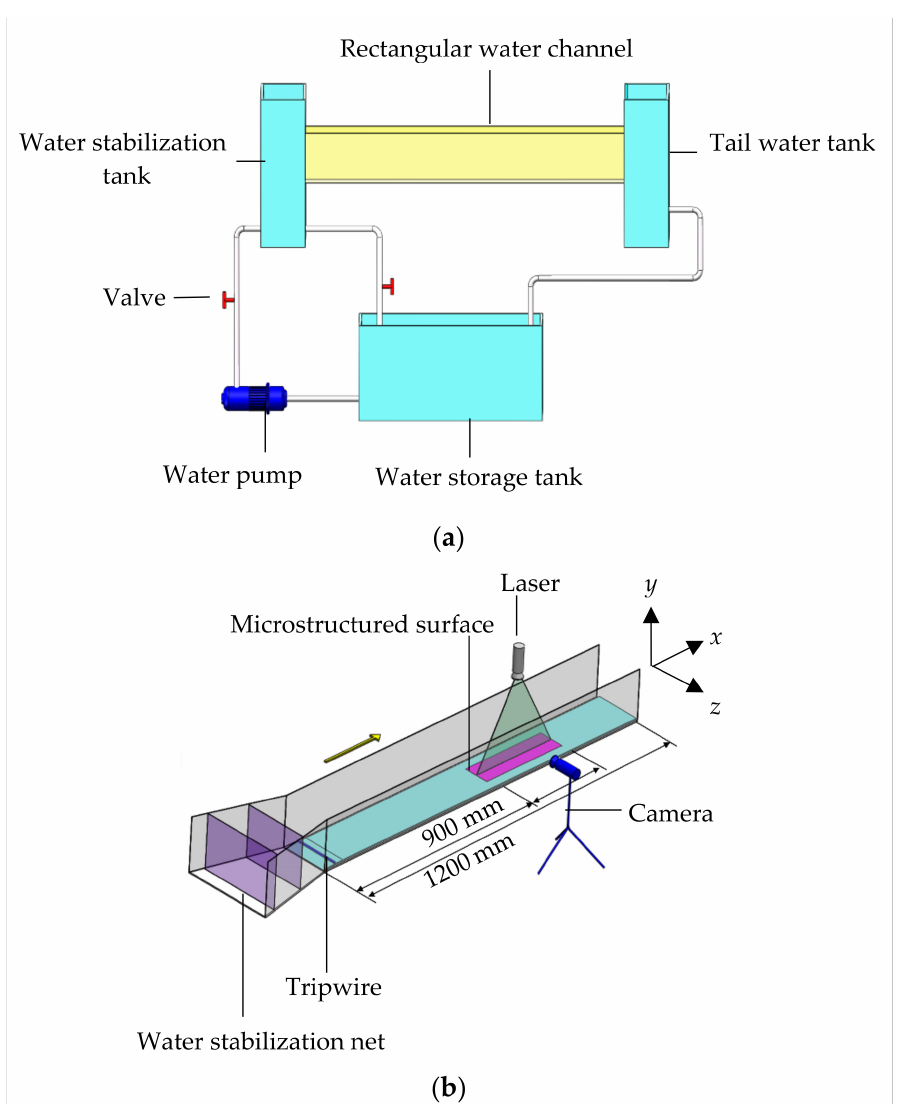
Figure 2. Schematic diagram of experimental devices. ( a ) Schematic diagram of experimental devices. ( b ) Rectangular water channel with a shrinking